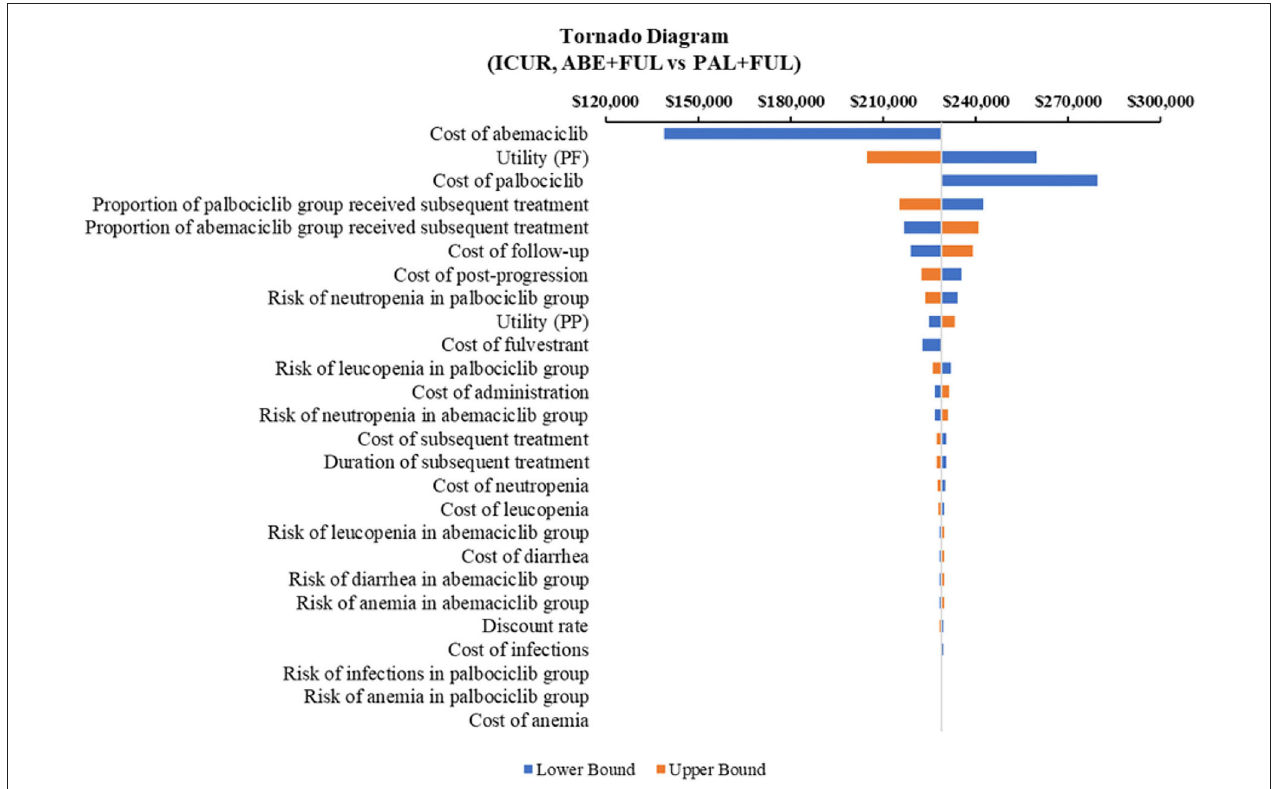
FIGURE 5 | Tornado diagram of the abemaciclib plus fulvestrant vs. palbociclib plus fulvestrant. ICUR, incremental cost-utility ratio; ABE, abemaciclib; PAL, palbociclib; FUL, fulvestrant.